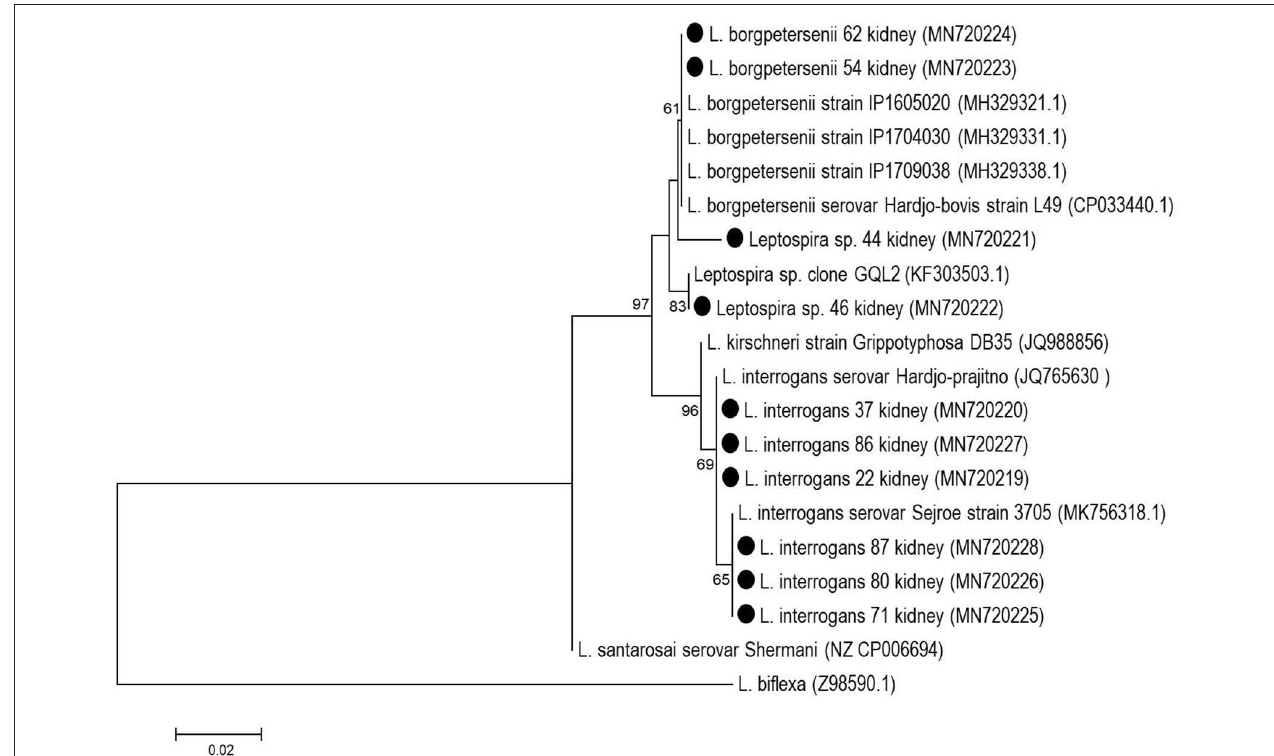
FIGURE 2 | Phylogenetic reconstruction based on partial rrs gene of Leptospira spp. from kidney samples of buffaloes (black circles). The tree was elaborated with Neighbor-Joining method, Tamura-3 parameter model with bootstrap test of 1,000 replicates.